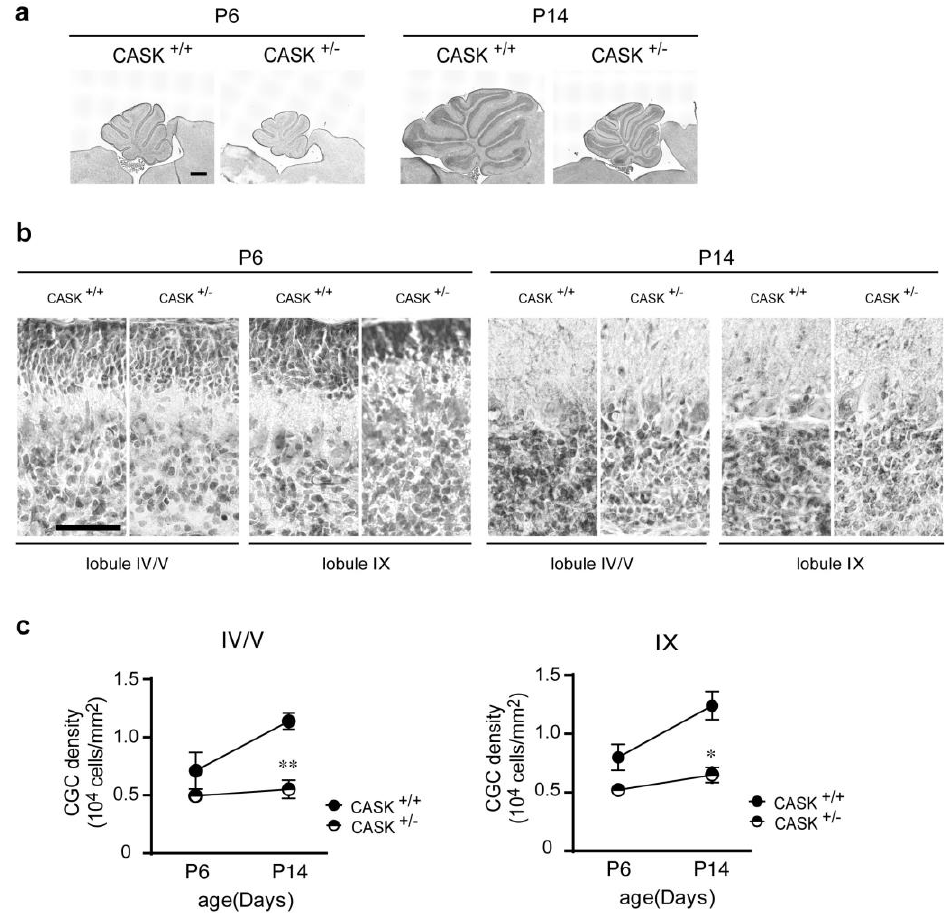
Figure 1. Progressive loss of CG cells in heterozygous CASK-KO mice. ( a ) Developmental neuroan- atomical changes of the cerebella of wild-type (CASK+/+) and heterozygous CASK-KO (CASK+/−) mice. Parasagittal cerebellar sections prepared from 6- and 14-day-old wild-type and heterozygous CASK-KO mice are stained with hematoxylin. Scale bars = 500 μm. ( b ) Magnified images of the cerebellar cortex of 6- and 14-day-old mice in a. Lobules IV/V and IX are shown. Scale bar = 50 μm. ( c ) Quantification of developmental changes in CG cell densities in control and heterozygous CASK- KO mice. All values represent the mean ± s.e.m., n = 3 each from three animals. ** p < 0.01, * p < 0.05; Student t -test. 3.2. Apoptosis Occurs in CASK KO CG Cells To investigate the effect of CASK deficiency on cell death in CG cells, we established a CG cell dissociated culture [33]. For this, we prepared CG cell cultures from CASK ho- mozygote floxed mice and infected with lentiviruses expressing iCre recombinase under the control of the rat synapsin1 promoter and generated CASK KO CG cells. CASK floxed CG cells infected with empty lentiviruses were used as control. We confirmed that immu- noreactivity to the CASK protein was absent in iCre-infected floxed CG cell cultures (Fig- ure 2a). To investigate the time course of cell death, we quantified the density of CG cells at DIV3, DIV5, DIV7, and DIV9 in control and CASK KO cultures by immunostaining with NeuN antibody, a marker for CG cells. The density of CG cells was progressively decreased in CASK KO CG cells (Figure 2b,c). To examine whether CG cell death is due to apoptosis or not, we performed a TUNEL assay on CG cell cultures. We compared TUNEL signals between control and iCre-infected CG cell cultures from wild-type and floxed CASK mice at DIV7 (Figure 2d,e). TUNEL- positive CG cells were significantly increased in CASK KO CG cells, suggesting that cell death in CASK KO CG cells was caused by apoptosis (Figure 2d,e).